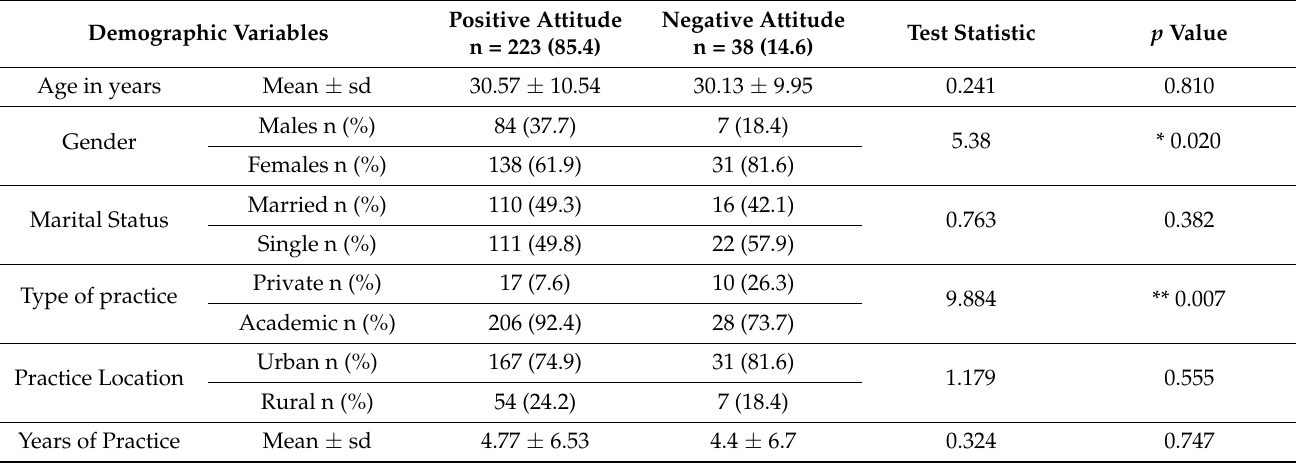
Table 5. Comparison of the demographic variables in relation to the attitude (chi-square test for independence of